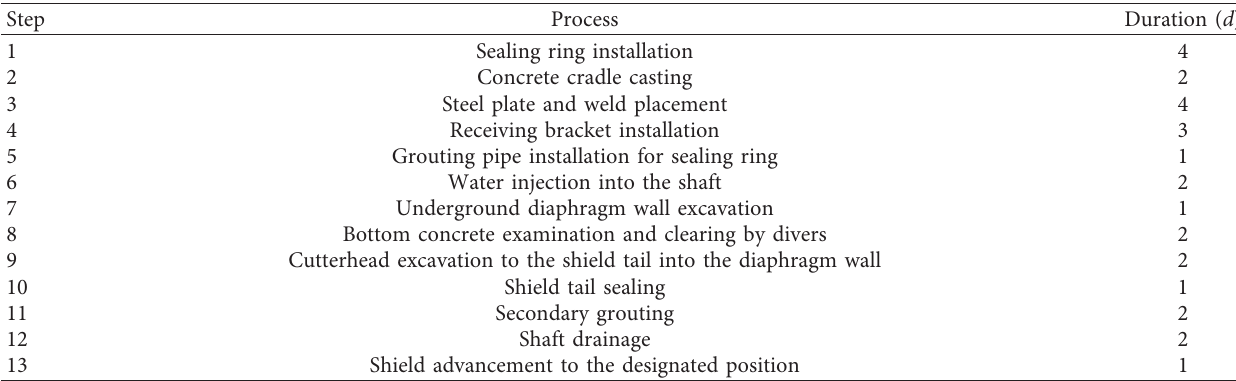
Table 3: Underwater recovery schedule of shield.